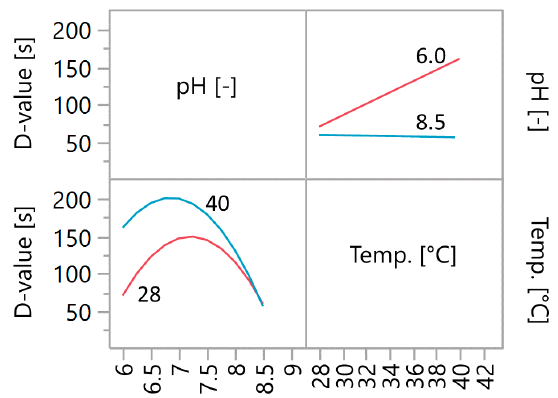
Figure 3. Interaction profiles of pH and temperature. The influence of temperature on the D-value increases with decreasing pH. The pH value at which the greatest D-value is expected shifts from 7.2 to 6.9 when the temperature rises from 28 to 40 °C.